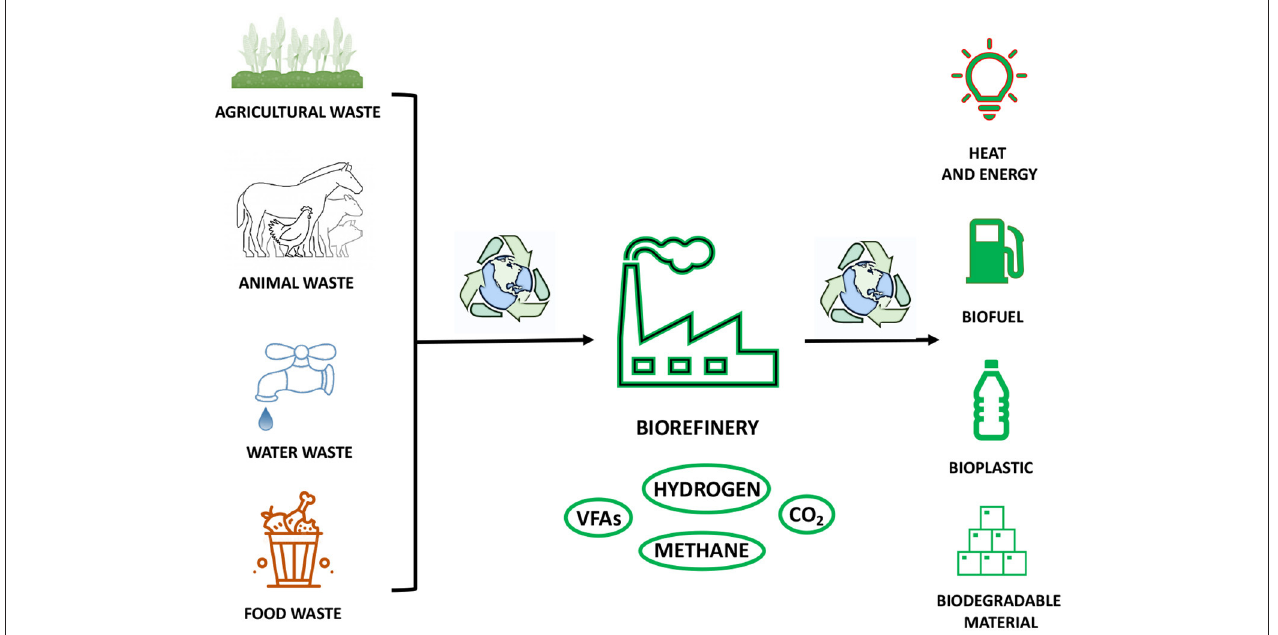
FIGURE 7 | The cartoon is a representation of the use of organic waste in the biorefinery process to obtain valuable products in a sustainable and environmentally friendly manner.